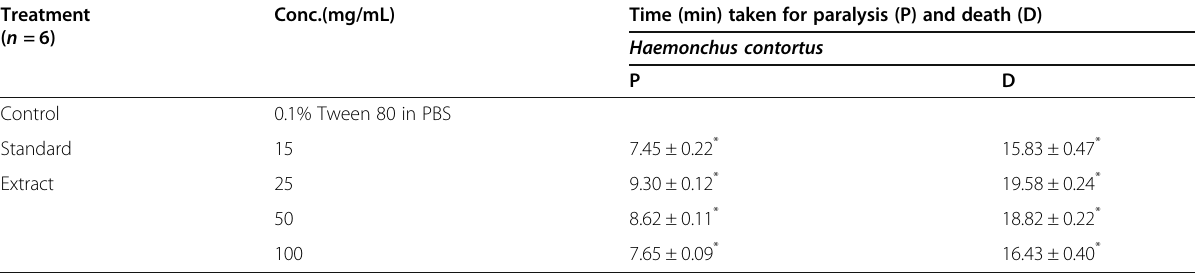
Table 3 Effect of ethanolic extract of M. umbellata on Haemonchus contortus Treatment ( n =